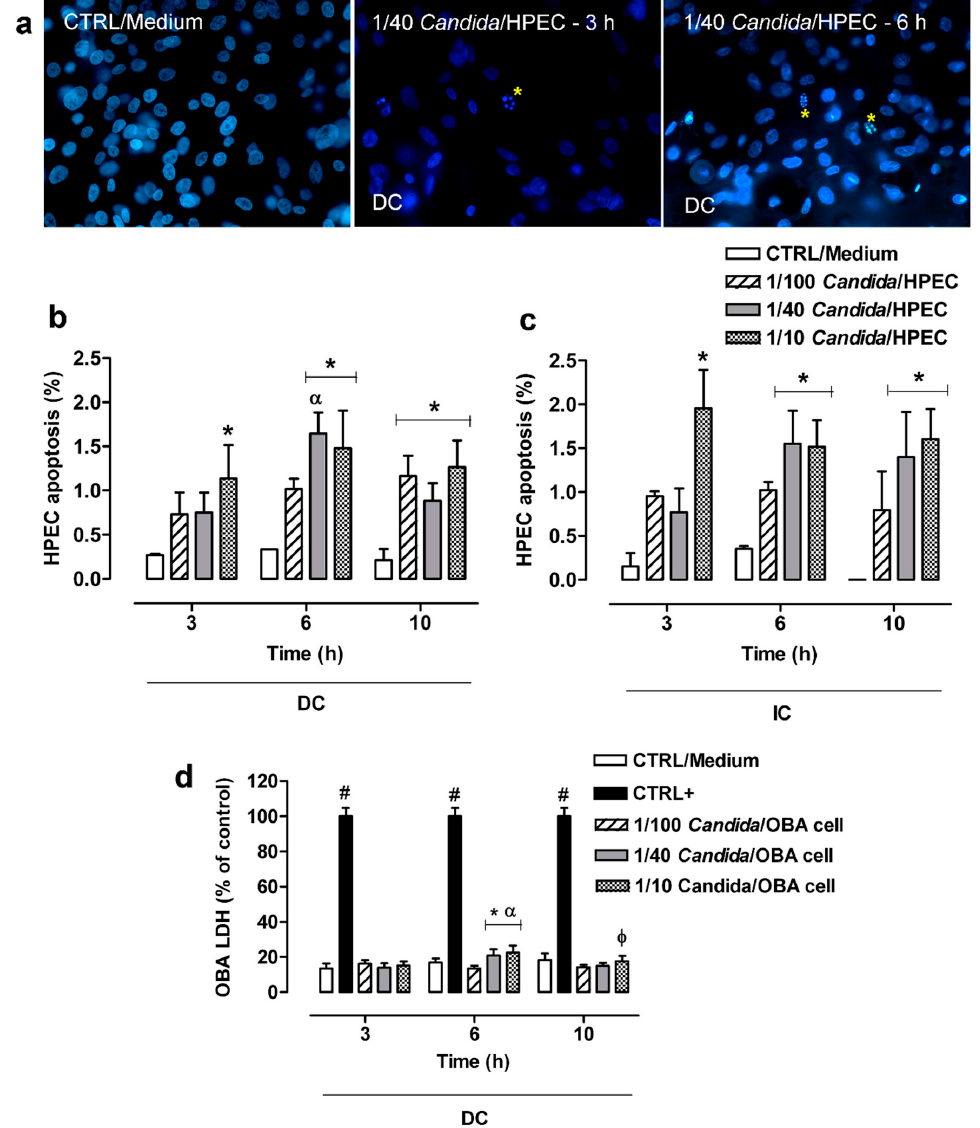
Figure 3. Cytotoxic effects induced in human palate epithelial cells (HPECs) by different C. albicans ratios over time. ( a ) HPECs underwent typical morphological apoptosis after direct contact (DC) with C. albicans . The DNA-binding dye showed nuclear chromatin morphological features as a quantitative apoptosis index within the cell culture system. * Apoptotic bodies. Hoechst 33,258 staining (fluorescence microscope, ×400 magnification). ( b and c ) HPEC apoptosis analysis between different fungal ratios after DC or indirect contact (IC) with C. albicans over time. ( d ) Cytotoxic effects were measured by lactate dehydrogenase (LDH) enzymatic activity in cells of the immortalized human gingival epithelial cell line OBA-9 after DC with the fungus (*) p < 0.02 compared to unchallenged cells (CTRL/Medium) at the same time. (#) p < 0.001 compared to all Candida /OBA cell ratios at the same time. ( α ) p < 0.04 compared to all other times. ( φ ) p < 0.03 compared to 1/100 Candida /OBA cells at 10 h. Results are expressed as the mean ± SEM of at least three independent experiments performed in triplicate with the factorial ANOVA contrast test.